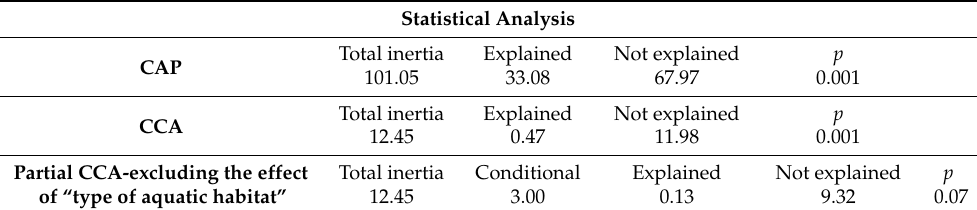
Table 2. Results of the statistical analysis carried out to determine whether species occurrence is affected by physicochemical parameters and type of aquatic